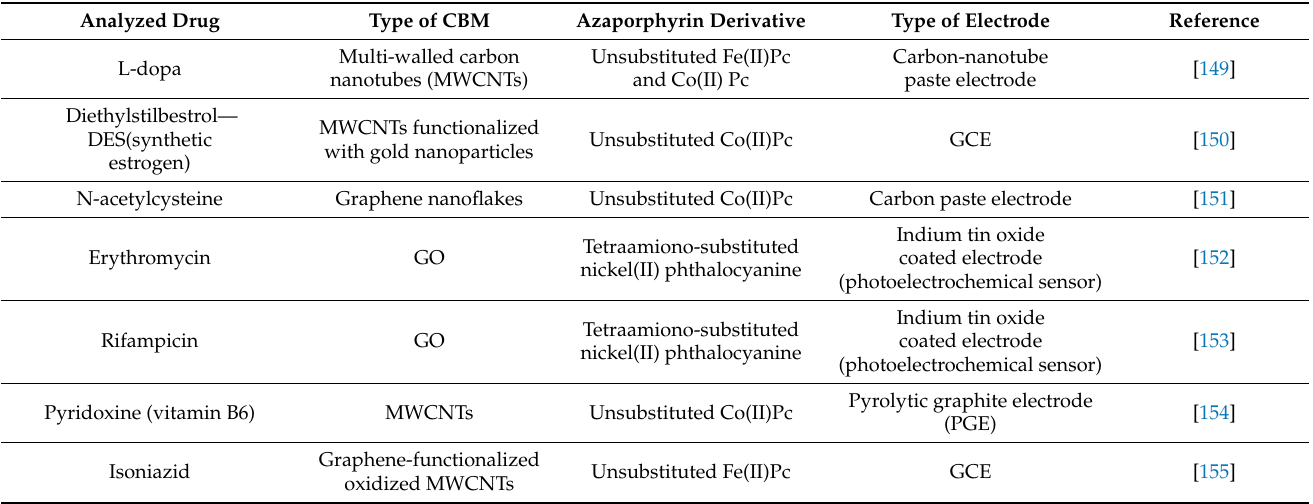
Table 1. Examples of active pharmaceutical ingredients (APIs) subjected to electrochemical determination with the use of Pcs/CBNs modified